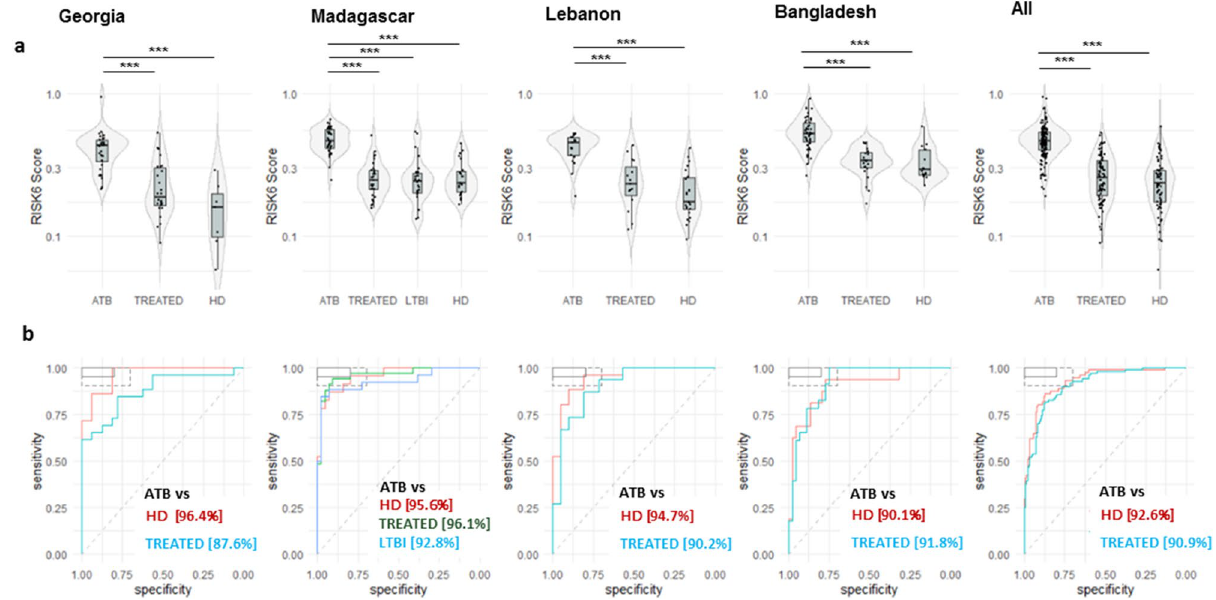
Figure 1. Validation of the performance of a multi-cohort 6-gene signature; RISK6 as a screening and triage test in patients with pulmonary TB. ( a ) Violin plots showing the differences in the levels of RISK6 signature scores from patients with active TB at baseline (ATB, n = 141), treated TB patients (TREATED, n = 97; patients with a negative sputum culture at T2 and/or T3), individuals with a latent TB infection (LTBI, n = 26), and healthy donors (HD, n = 71) from Georgia, Madagascar, Lebanon, Bangladesh and in all sites. Horizontal lines designate medians, boxes represent the inter-quartile ranges (IQR) and the ranges are represented by whiskers. Single patient results are represented by each dot in the graph. Statistical significance was calculated using Mann–Whitney U test. *Indicates a p-value < 0.05, **indicates a p-value < 0.01, and ***indicates a p-value < 0.001. ( b ) Receiver operating characteristic (ROC) curve analysis and the respective areas under the curve (AUC) with 95% confidence intervals showing the performance of the RISK6 signature to discriminate between ATB patients at baseline, HD and LTBI. In the top left box, the solid and dashed lines represent the respective optimal and minimum criteria set by the WHO in the target product profile (TPP) for a screening/ triage test for